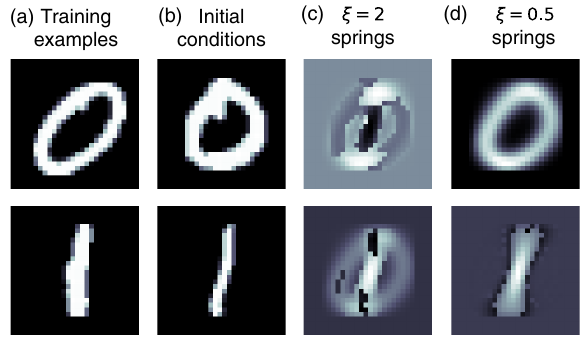
FIG. 6. Elastic networks learn to recognize handwritten